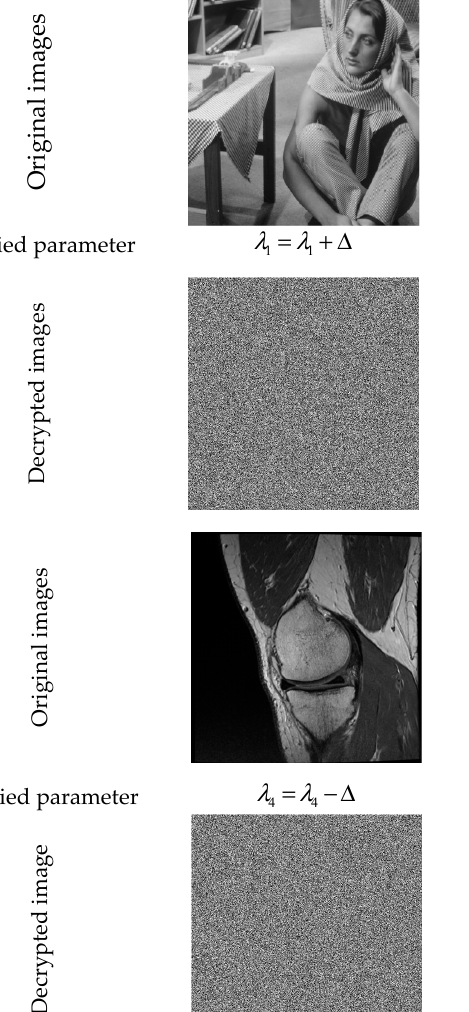
Table 2. Comparison in terms of security key space of recent encryption scheme, including the proposed one. Encryption Scheme